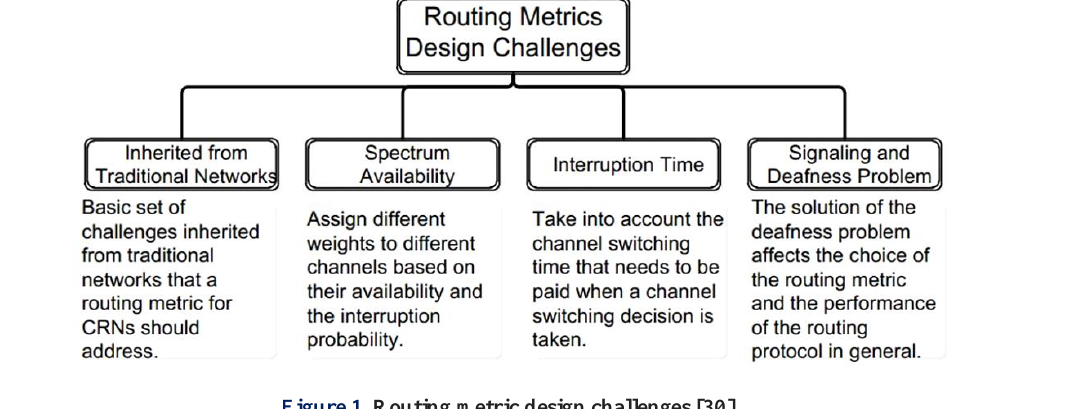
Figure 1. Routing metric design challenges [30].